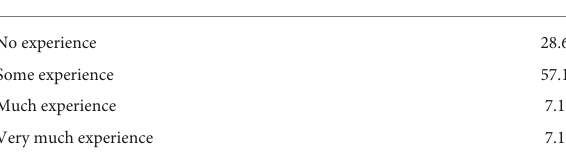
TABLE 1 Experience of the sample ( N = 242, N = 210 valid